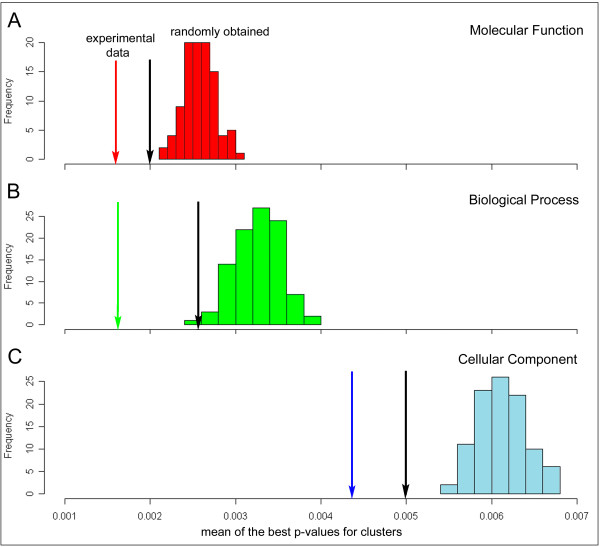
Statistical significance of Markov chain graph clustering results. The best p-values for over-representations of Gene Ontology (GO) terms, averaged over all clusters (S score, denoted by color arrow) are compared to the analogous values for 100 randomly-obtained clusterings (histogram). GO categories: (A) Molecular Function, (B) Biological Process, (C) Cellular Component. In each case, the actual clustering scored significantly better than any of 100 randomly obtained ones (Wilcoxon test p-value < 2.2 × 10-16). In a comparison of the MCL (Markov clustering) and k-means clustering results (the latter denoted by black arrows), MCL had better S scores for GO terms overrepresentation than the k-means method (0.0016 versus 0.0020 for "Molecular Function" category; 0.0016 versus 0.0026 for "Biological Process"; and 0.0044 versus 0.0050 for "Cellular Component").